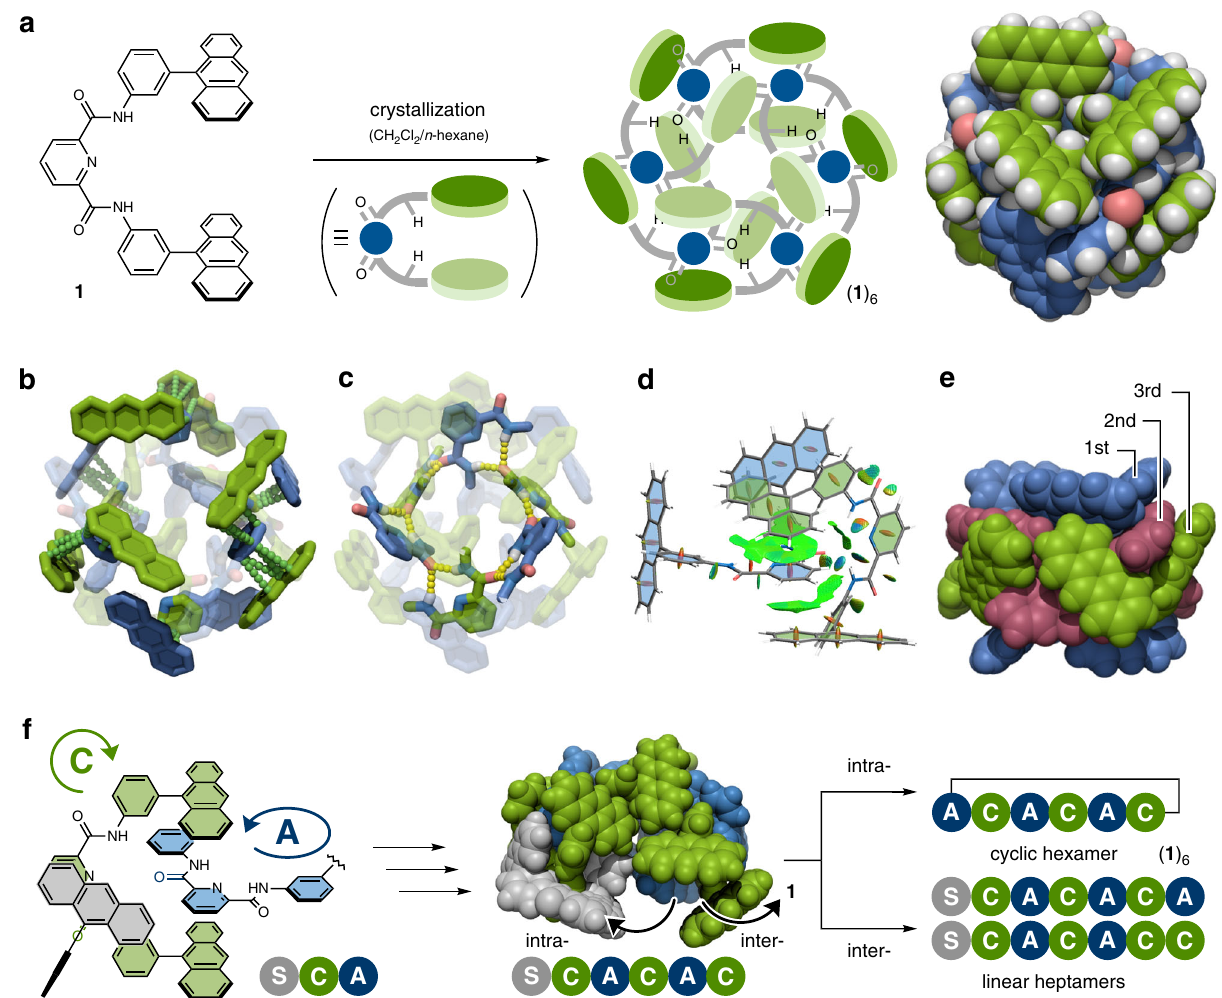
Fig. 2 | Formation of a self-complementary macrocycle. a Formation of self- complementary macrocycle ( 1 ) 6 , and its X-ray crystal structure. Highlighted inter- actions in ( 1 ) 6 : b π - π interactions (green dotted line) and c hydrogen bonding (yellow dotted line). d NCI plot calculated by the DFT method at the B3LYP-D3/6- 31G(d,p) level. A single unit of the head-to-tail complex was extracted for clarity